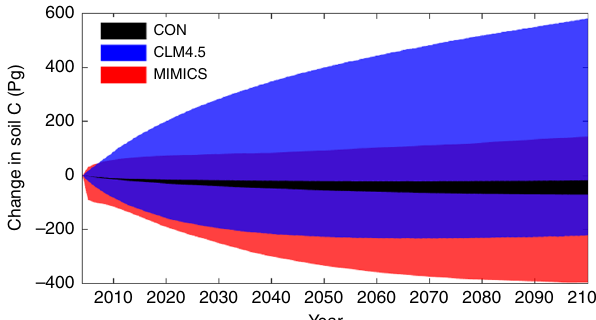
Fig. 4 Changes in global total soil carbon under RCP 8.5. 1000 parameter sets were randomly sampled from the posterior distribution of parameters to generate the temporal trajectories in each model. The shaded area represents the 95% con fi dence interval generated by 1000 parameter